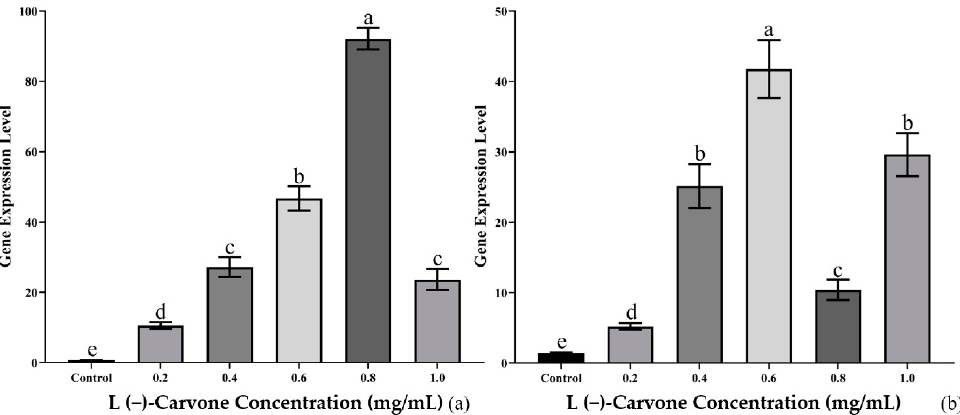
Figure 5. Gene expression of Bx-cyp29A3 treated with L( − )-carvone solutions. ( a ) 24 h treatment with L( − )-carvone solutions of 0.2, 0.4, 0.6, 0.8, and 1.0 mg/mL; ( b ) 36 h treatment with L( − )-carvone solutions of 0.2, 0.4, 0.6, 0.8, and 1.0 mg/mL. Notes: Data are mean values ± SD of different repetitions; n = 3. Different letters indicate statistical differences with p ≤ 0.05 from Student’s t -test.